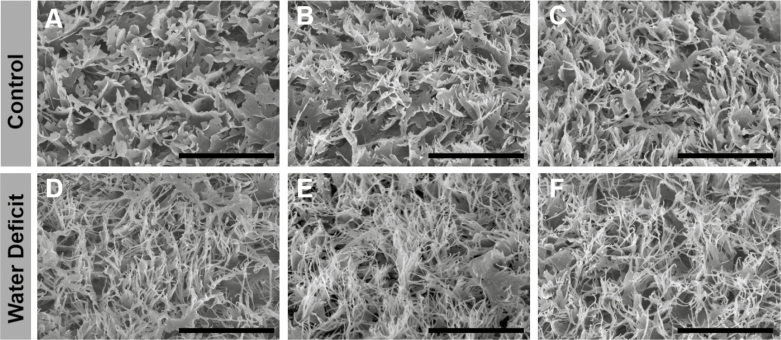
Ultrastructural morphology of cuticular waxes on grape berries at 113 days after anthesis (DAA). SEM images of the cuticular wax ultrastructure on grape berries of grapevines (Vitis vinifera L.) exposed to two irrigation treatments: (A–C) well-irrigated (control, CT); (D and E) deficit irrigated (water deficit, WD). Each image represents one biological replicate. The scale bar represents 5 µm in all images.